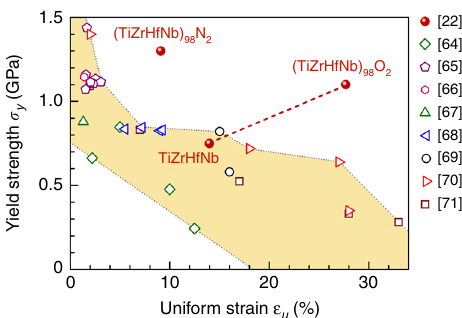
Fig. 4 Hysteresis loop in load – unload – reload tensile stress – strain curve of HEAs/MEAs tested at RT. These loops are recorded at respective maximum uniform tensile strain, i.e., at a strain close to necking on the stress – strain curve. The loop widths cited here are by far the widest for all alloys reported in the literature to date. This indicates that the heterogeneous microstructures in these HEAs generate high back stresses that contribute to strengthening and strain hardening. The back stresses can be estimated from the loop using unload residual plastic strain and yield stresses upon unloading and reloading 15,23 . After the fi rst report in ref. 23 , similarly wide hysteresis loops have been observed in other heterogeneous HEAs, as summarized in this